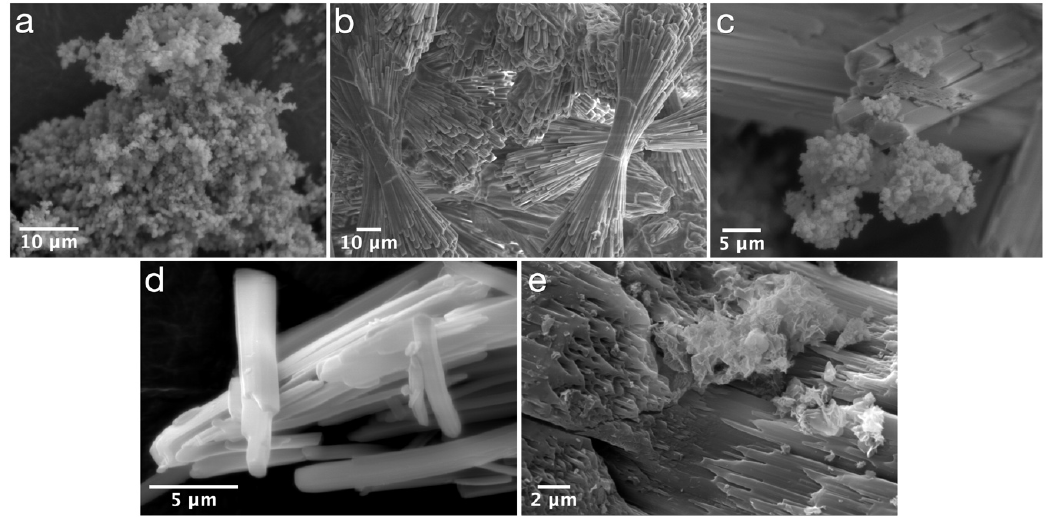
Figure 2. Scanning electron micrographs of carbonate products (acquired in variable pressure mode), showing representative morphologies from aqueous syntheses ( a – c ), from scCO 2 -od ( d ) scCO 2 -hpd ( e ). With MgSO 4 as precursor (25 min reaction, 21 °C), we obtained a product with a mor- phology of rods of ca. 20 µm, conjoined and extending from a compact center (Figure 2b).